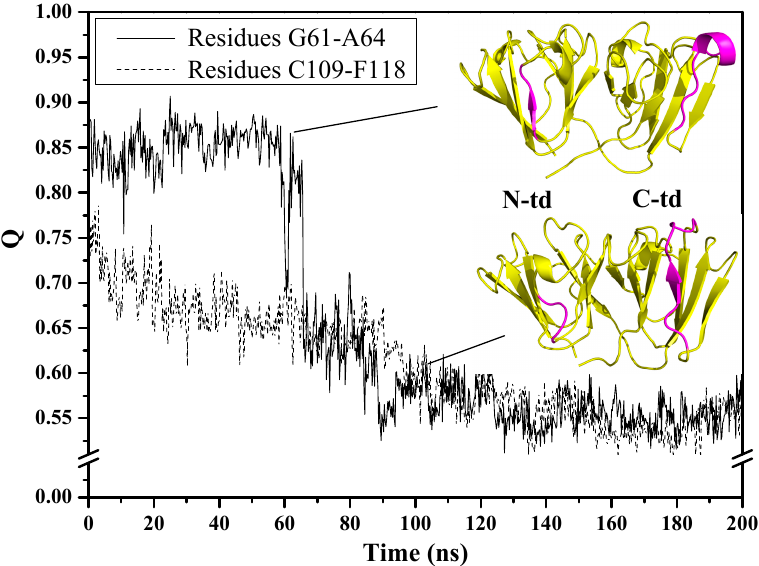
Figure 3. Contact fraction (Q) for specific residue regions in the urea-induced HGDC structure as a function of time in physiological solution, 343 K.